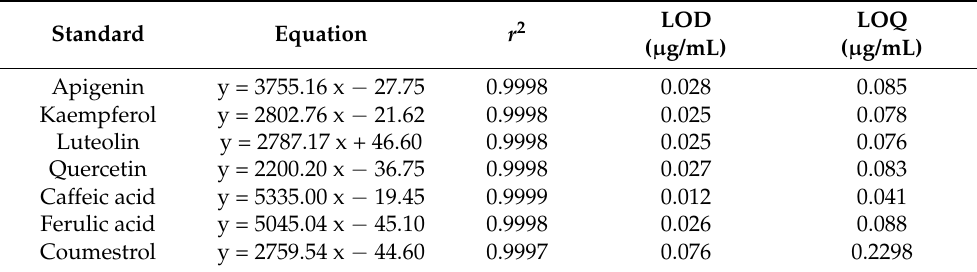
Table 7. Calibration curve parameters for selected phenolic